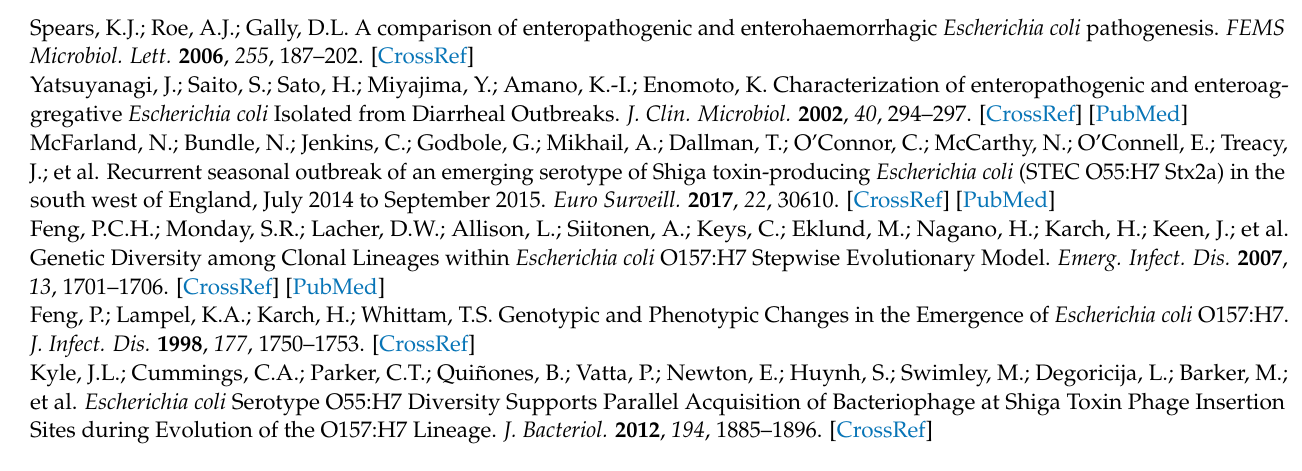
E. coli O55:H7 chromosomes, Figure S2: Comparison of stx -encoding prophages in O55:H7 to related prophages and stx genes, Figure S3: Integration site of stx2 d prophage in O17/O44:H18 compared to the prophages integrated into the same site in O55:H7 and STEC O157:H7, Figure S4: Additional plasmid identified in O55:H7 strains, Figure S5: Comparison of pDEC5B-4 to pO157, pO55, and additional pO55 plasmids, Figure S6: Comparison of the phylogenetic trees from the chromosome and pO55 plasmids from O55:H7. Table S1: Strains used in the study with associated metadata, Table S2: The prophage content of each strain as determined by PHASTER, Table S3: The insertion element content of E. coli O55:H7 strains as determined by NCBI annotation, Table S4: The unique gene content of E. coli O55:H7 strains as determined by